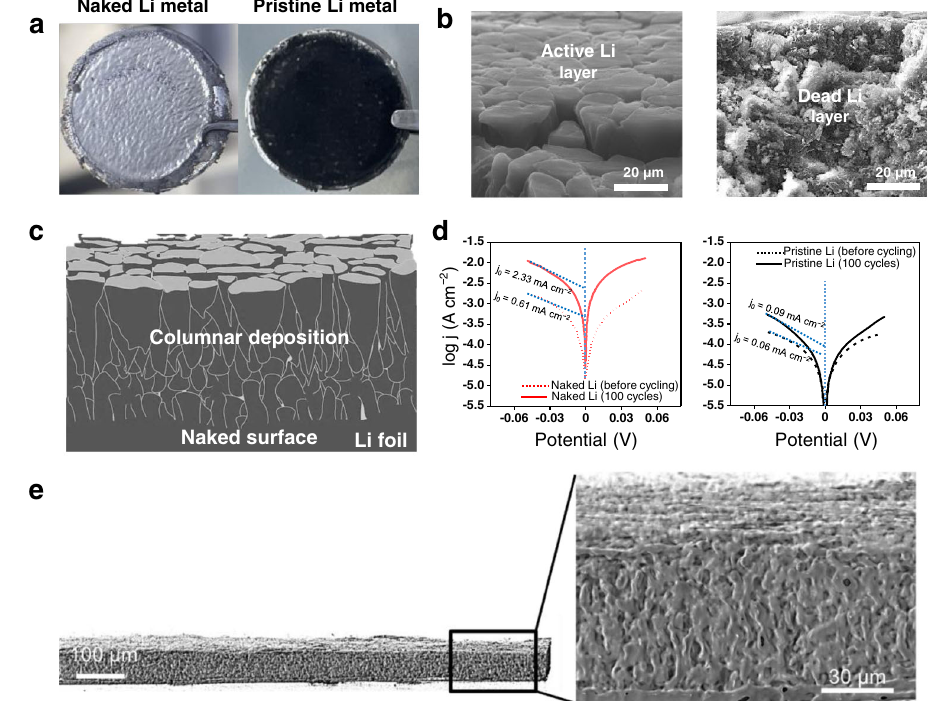
Fig. 7 | In fl uence of naked Li surface on the deposition layer. a Photographs of the naked (left) and pristine (right) Li metal foils after 100 th Li plating. Cycling conditions: 1mAcm − 2 , 1mAh cm − 2 . b SEM images of the active Li layer (left) on the previouslynakedLimetalfoilandthedeadLilayer(right)onthepreviouslypristine Li metal foil after 100 cycles at 1mAcm − 2 with 1mAh cm − 2 . c Schematic illustration